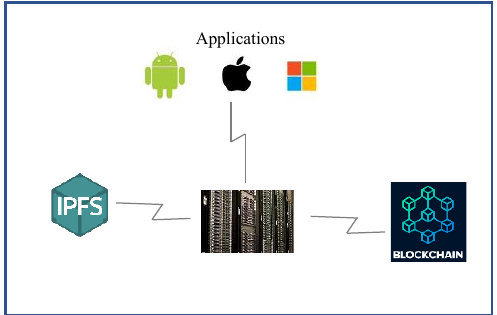
Fig. 3.1 System Overview